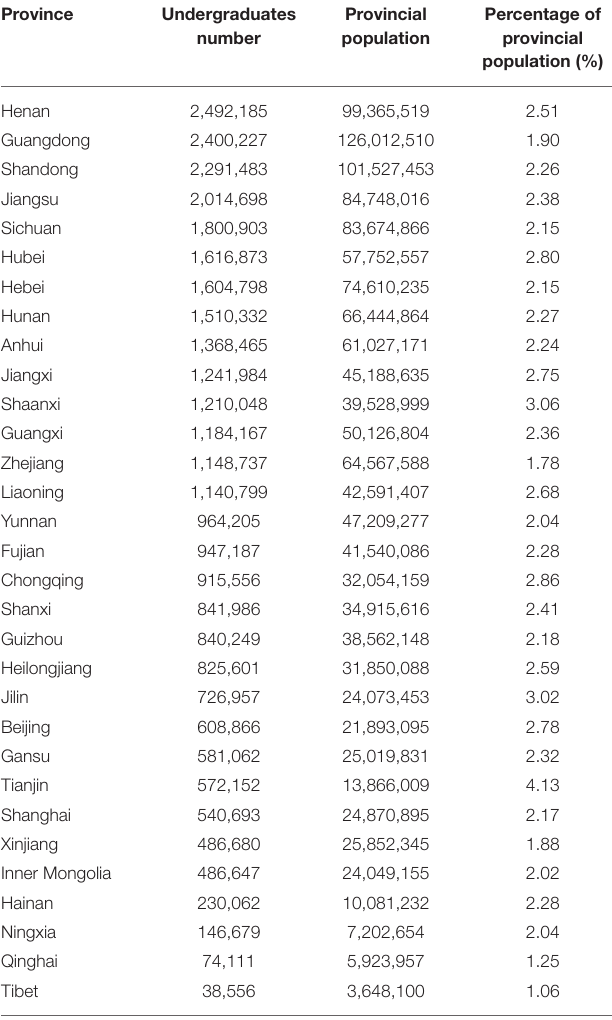
TABLE 1 | Number of regular students for normal and short-cycle courses in higher education.